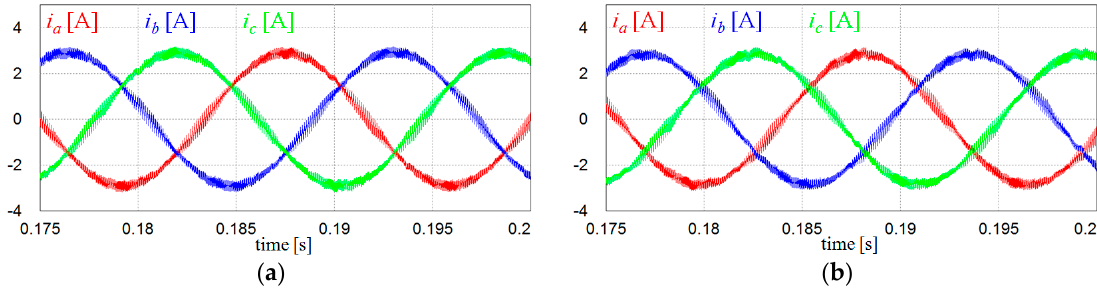
Figure 9. Comparison of inverter output currents under the ideal grid condition. ( a ) Inverter output currents with voltage measurements; and ( b ) inverter output currents with the proposed voltage-sensorless control.